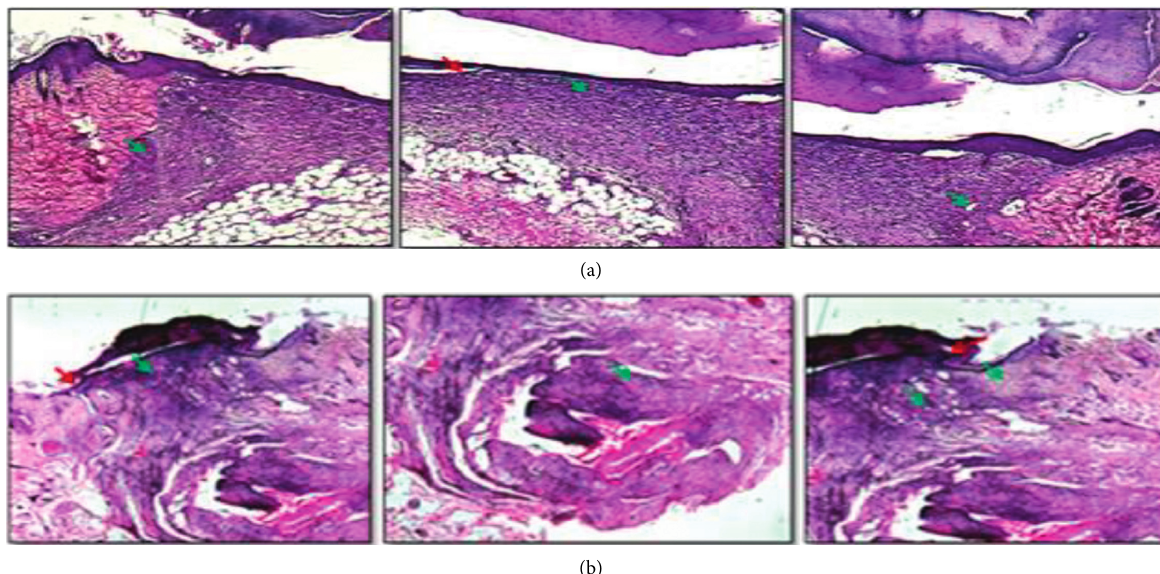
Figure 8: (a) Control (untreated) and (b) TSP gel treated: photomicrographs of H &E-stained images showing the wound edges and wound crater. Epithelialization is marked by a red arrow and collagen formation by green arrows.